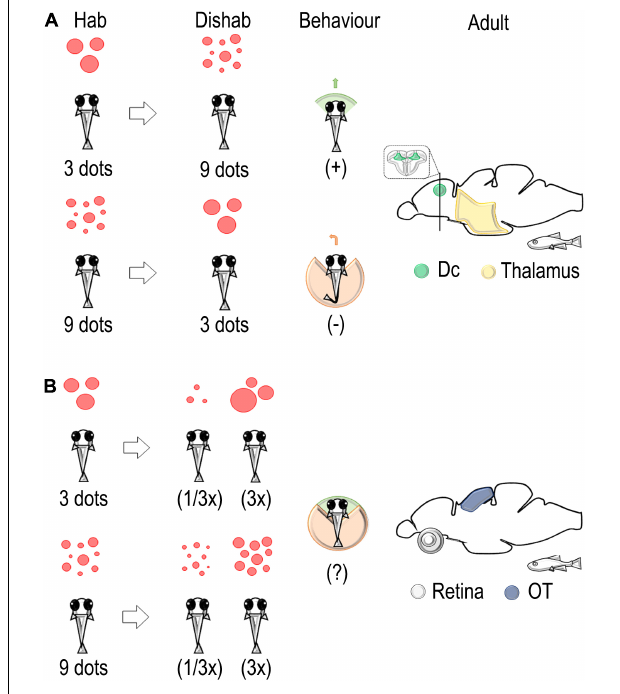
FIGURE 3 | Schematic representation of the habituation/dishabituation paradigm used to identify neural correlates associated with a change in discrete and continuous magnitude in the adult zebrafish brain. (A) A change in number from 3 (habituation) to 9 (dishabituation) dots elicits an approach interaction. On the contrary, avoidance of the stimulus is detected in the change from 9 to 3 dots. An evaluation of immediate early genes (IEG) expressions revealed the main role of the thalamus and the dorso-central pallium (Dc) in the elaboration of changes in discrete quantity (numerosity) (Messina et al., 2020, 2022). (B) A change in size, i.e., a decrease (1/3x) or an increase (3x), revealed the main role of the retina and the optic tectum in the elaboration of continuous quantity (stimulus size) (Messina et al., 2020,